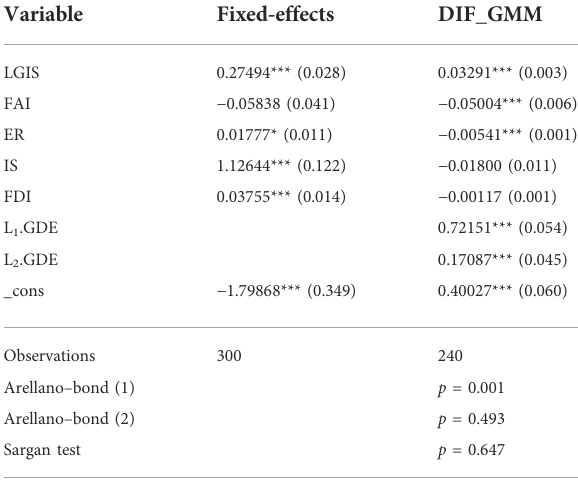
TABLE 6 Robustness test results: the dynamic panel difference GMM model.